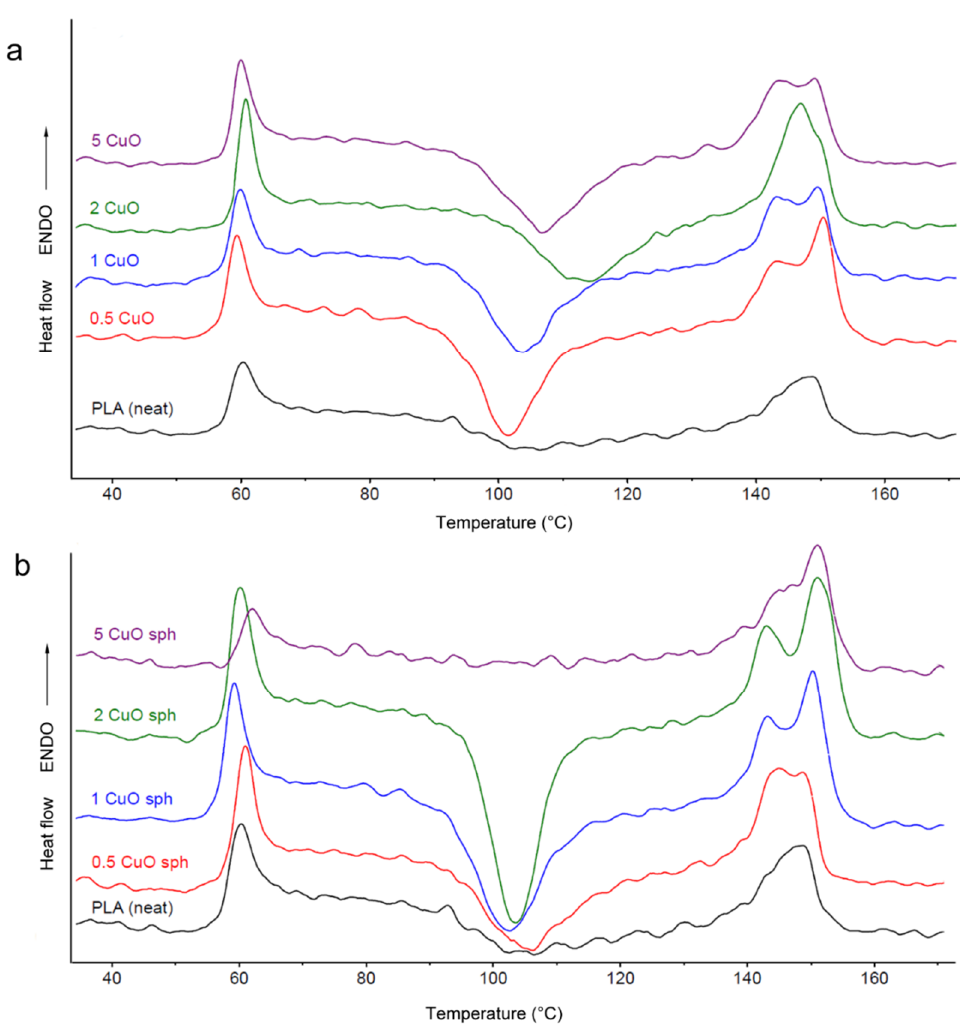
Figure 8. DCS curves of first heating of the neat PLA and PLA-based composites: containing 0.5–5 wt% CuO powder ( a ); 0.5–5 wt% CuO microspheres ( b ). 0.5–5 wt% CuO powder ( a ); 0.5–5 wt% CuO microspheres ( b